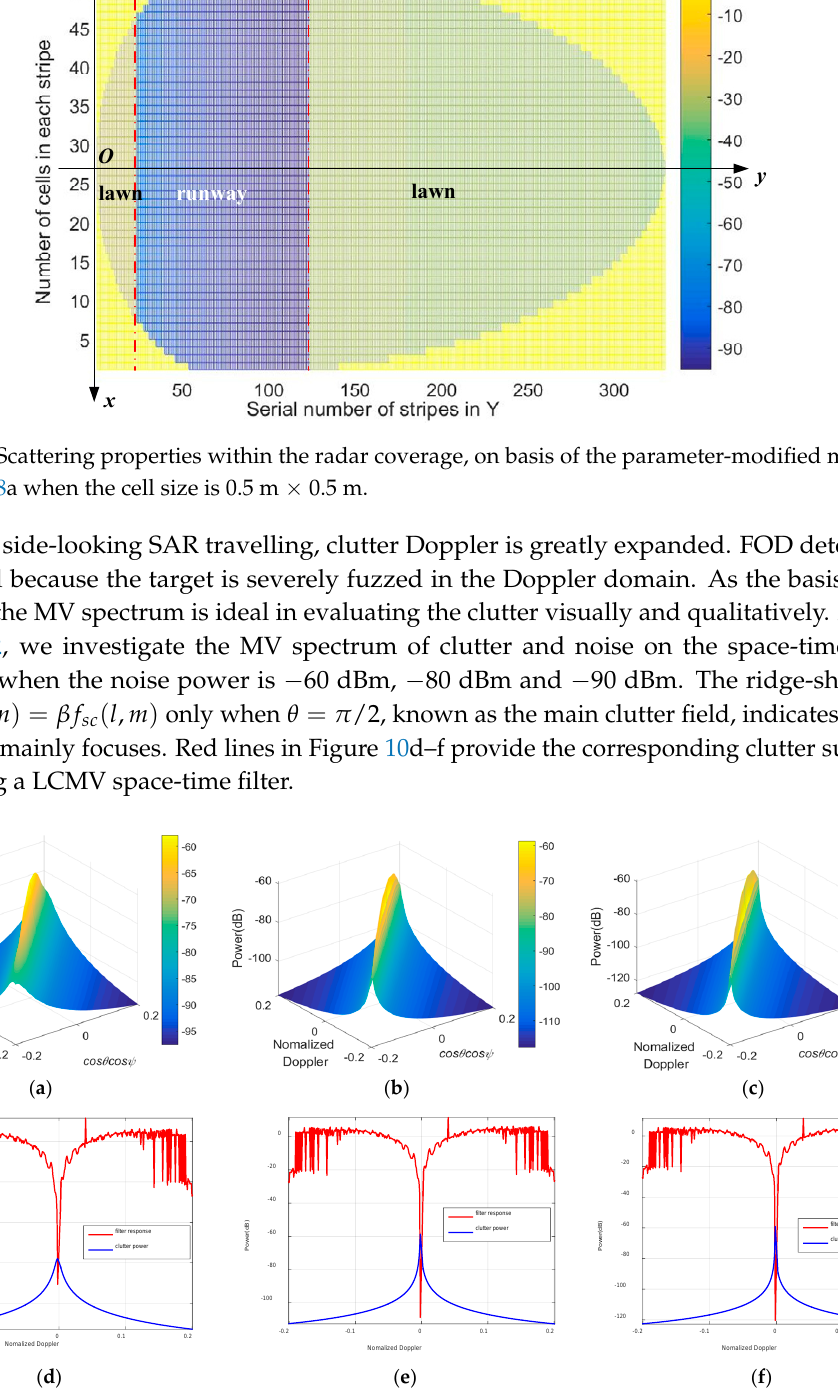
Figure 8. ( a ) Comparison between traditional Kulemin model and the data fitting results; ( b ) cos𝜃 cos𝜓 of each cell ranges from − 0.2006 to 0.2006, which constrains 𝐯 (cid:2929)(cid:2930) , 𝐯 (cid:2914)(cid:2930) , 𝐯 (cid:2929)(cid:2913) , and 𝐯 (cid:2914)(cid:2913) .